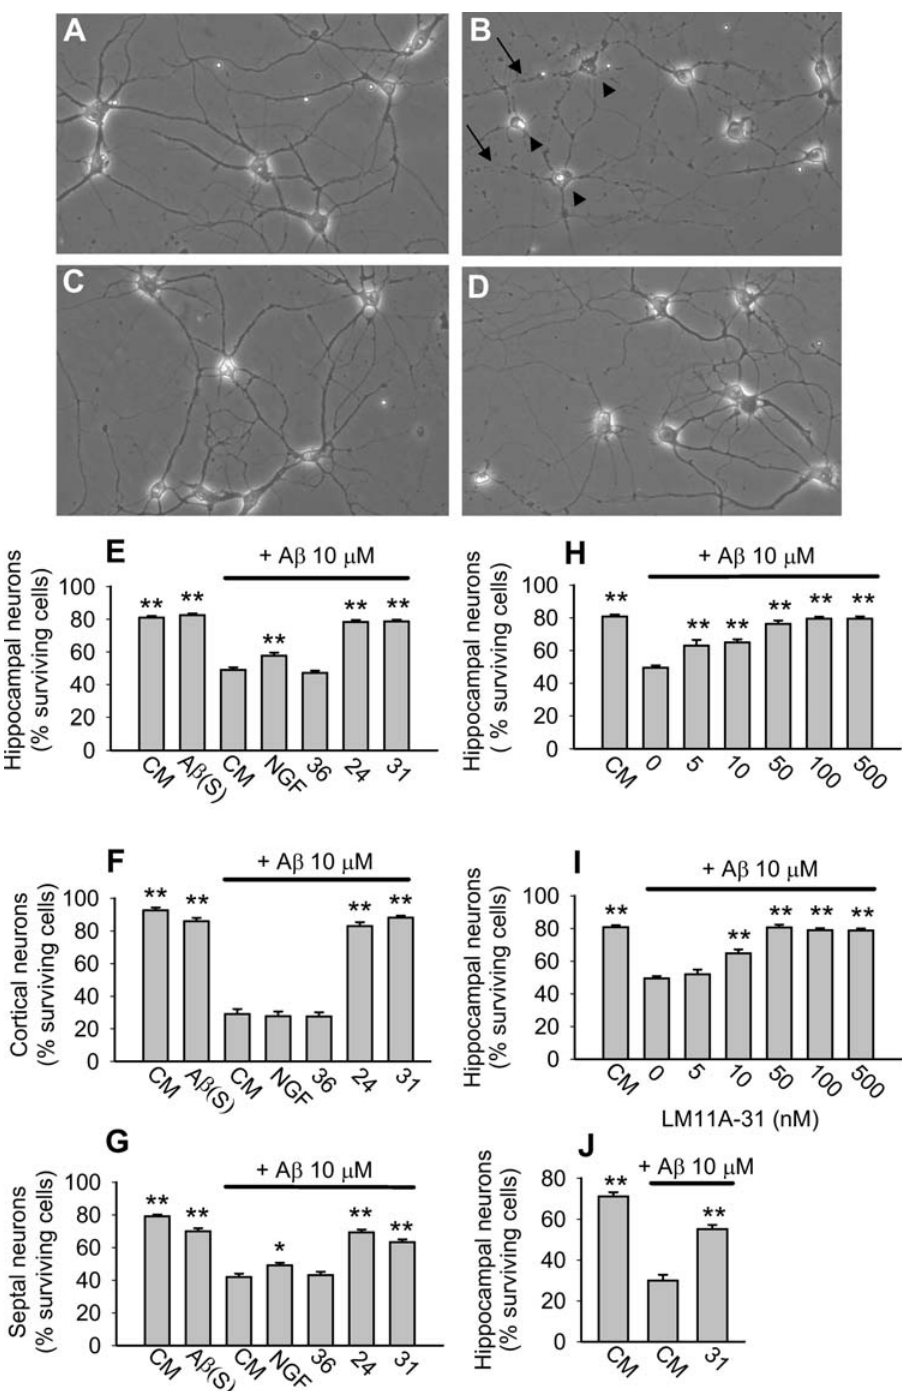
Figure 1. p75 NTR small molecule ligands protect neurons from A b -induced death. 6–7 DIV hippocampal, cortical and septal neurons were exposed to: culture medium alone (CM); CM containing 10 m M A b (S), a control peptide containing A b (1-42) residues in a scrambled sequence; 10 m M A b alone or with NGF (100 ng/ml , , 4 nM), LM11A-24, -31, or -36 (100 nM). After 72 hours, cultures were fixed and photographed under phase contrast microscopy. (A) In CM alone, neurons had round, phase bright cell bodies with outgrowth of intact neurites (normal morphology). (B) In the presence of A b , many neurons exhibited the degenerative findings of cell body shrinkage (arrowheads), vacuolated cytoplasm, and neurite beading and fragmentation (arrows). (C, D) Neurons co-treated with A b and LM11A-24 (C ) or LM11A-31 (D ) exhibited normal morphology. (E–J) Neuronal survival was quantitated using morphological criteria (see Methods) and survival in each experimental condition was statistically compared to A b alone. In cultures of hippocampal (E ) cortical (F) and septal (G) neurons, A b significantly decreased survival while A b (S) had no effect. LM11A-24 and -31 inhibited A b -induced death while NGF and LM11A-36 negative control compound demonstrated no protective effects with the exception of NGF exhibiting a small protective effect in hippocampal and septal cultures (for hippocampal cultures, n=45–146 fields counted over 5–16 separate experiments; for cortical cultures, n=25–40 fields counted over 5 separate experiments; for septal cultures, n=50–60 fields counted over 6 separate experiments). (H, I) 6–7 DIV hippocampal neurons were exposed to CM alone or A b in the presence or absence of LM11A-24 (H) or -31 (I) at the